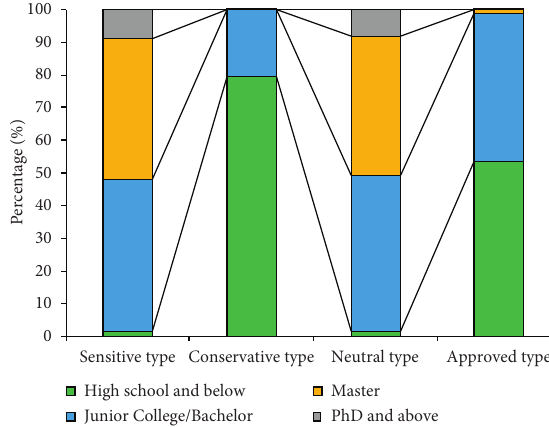
Figure 10: Education level of drivers in the four segments.